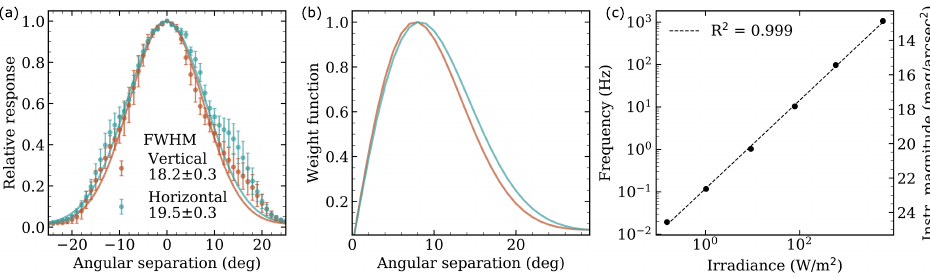
Figure 4. ( a ) FOV in the vertical (brown, defined in the IR window-thermometer direction) and horizontal (blue) axis, obtained in the laboratory by measuring received irradiance for different angles with respect to the optical axis. The FWHM obtained from the Gaussian fit in both axes is included. ( b ) Weight function of each FOV ring over the total flux. ( c ) Frequency measured by the TSL237 sensor against received irradiance; its approximate equivalence to magnitudes per square arcsecond is shown on the right axis. A fit is included to show the linearity of the detector to magnitudes greater than natural sky